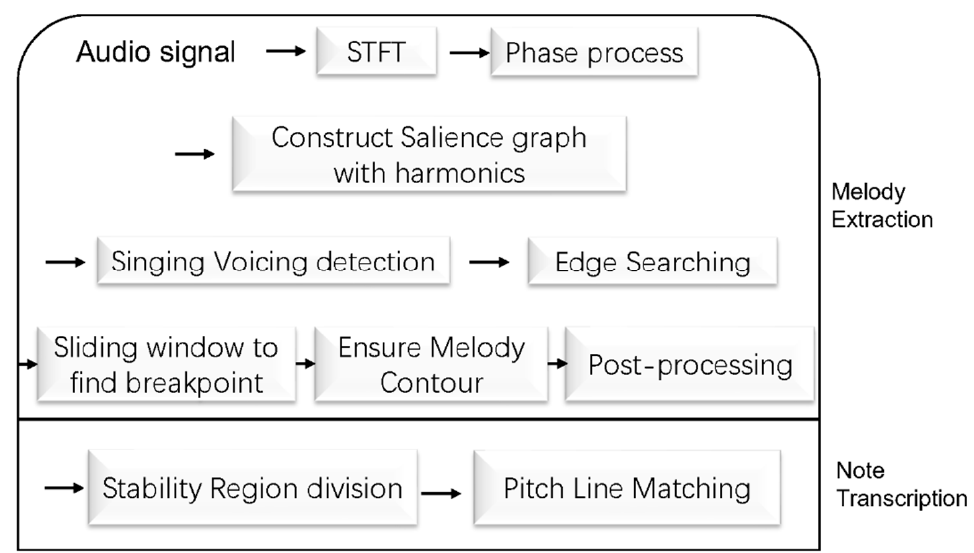
Figure 1. Block diagram: melody extraction and note transcription methods constituting the singing transcription system.